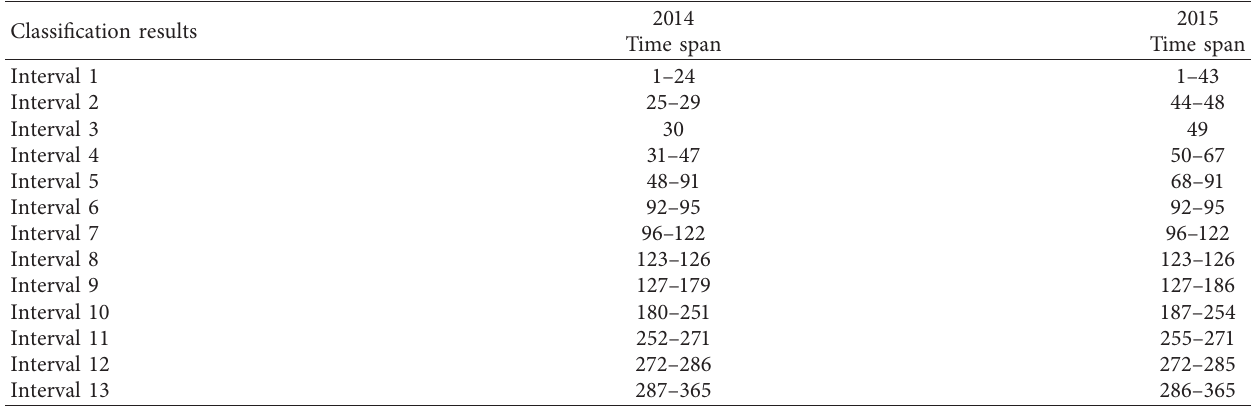
Table 1: Passenger flow intervals.